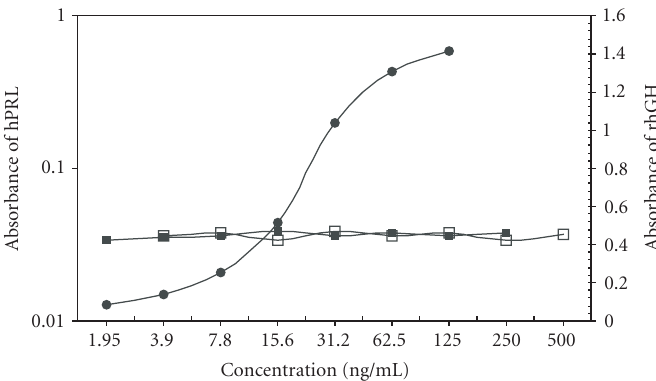
Figure 2. Estimation of cross-reactivity between both human prolactin, hPRL Sigma ( (cid:2) ) and hPRL Abbott ( (cid:1) ), and the rhGH • Genotropin, Pharmacia (